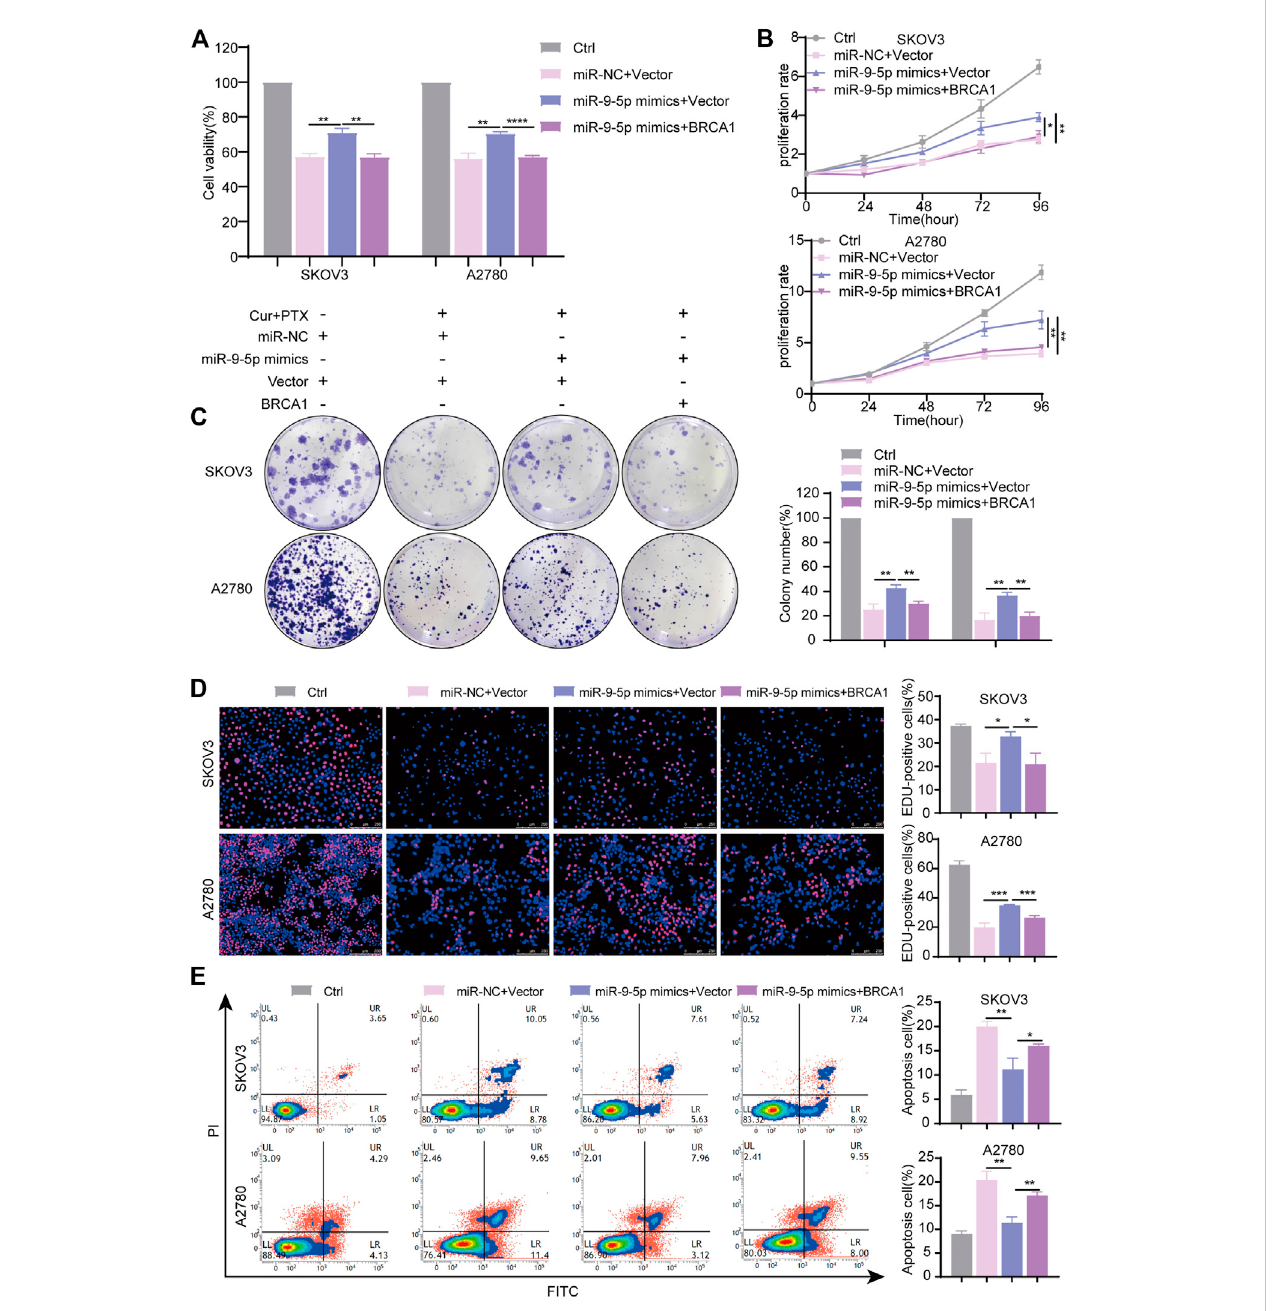
FIGURE 6 miR-9-5p counteracts the synergy between Cur and PTX by regulating BRCA1. SKOV3, and A2780 cells, transfected with miR-9-5p mimics, miR-9-5p mimics plus BRCA1 plasmid, and negative controls for 24 h respectively, were treated with DMSO, or Cur and PTX combination for a given time. (A) CCK-8 assays were performed to test cell viability. (B – D) CCK-8 assays, colony-formation assays and Edu incorporation assays were performed to detect the proliferative capacity of SKOV3 and A2780 cells. (E) Flow Cytometry were performed to analyse cell apoptosis. Data are representative of at least three independent experiments and presented as the mean ± SD. * p < .05, ** p < .01, *** p < .001, **** p <